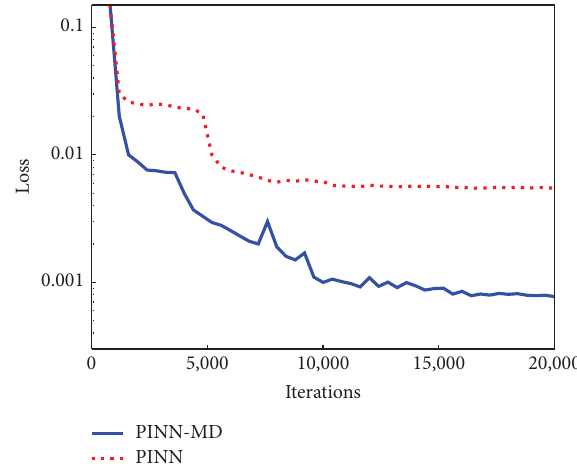
Figure 6: Training loss curve of PINN and PINN-MD with middle section